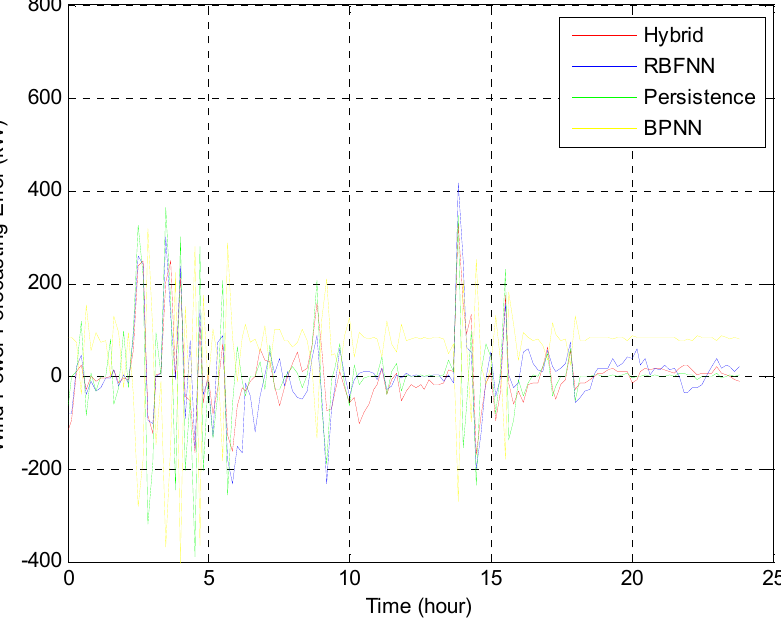
Figure 7. The forecasting error curves of four methods for typical winter